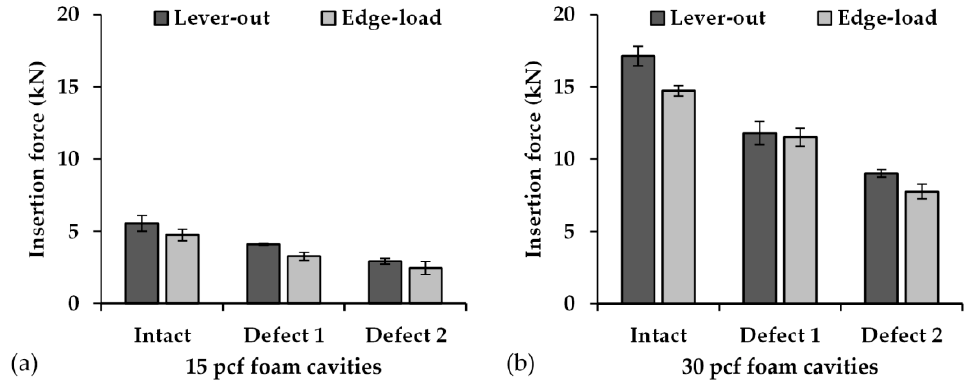
Figure 5. Comparison of the forces of the acetabular cup insertion for both the tilting methods: ( a ) for the PU foam with a density of 15 pcf and ( b ) for the PU foam with a density of 30 pcf. The insertion forces are presented as mean values ( n = 3), and the error bars represent SD.